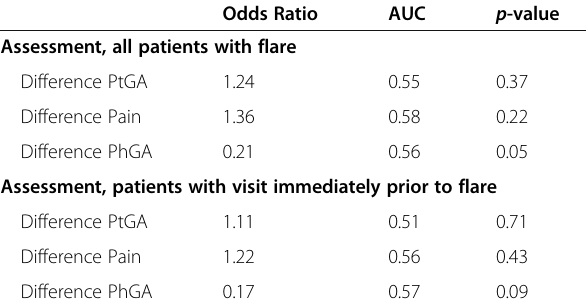
Table 3 Change in PtGA, pain & PhGA for all patients with